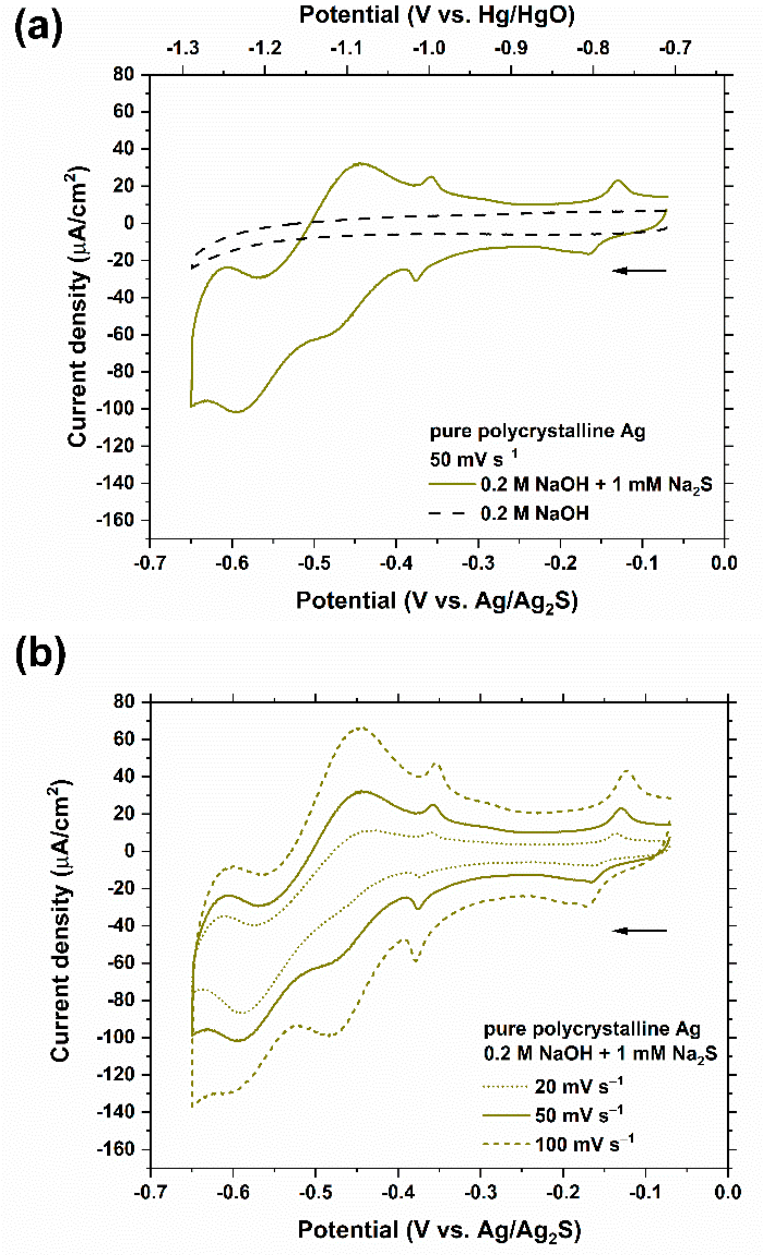
Figure 2. Cyclic voltammetry of a polycrystalline Ag electrode (0.38 cm 2 ) in 0.2 M NaOH solution with and without 1 mM Na 2 S ( a ) at a scan rate of 50 mV s − 1 ; ( b ) and in the presence of 1 mM Na 2 S at different scan rates (20, 50, 100 mV s − 1 ). The arrow indicates the starting point and the scan di- rection.